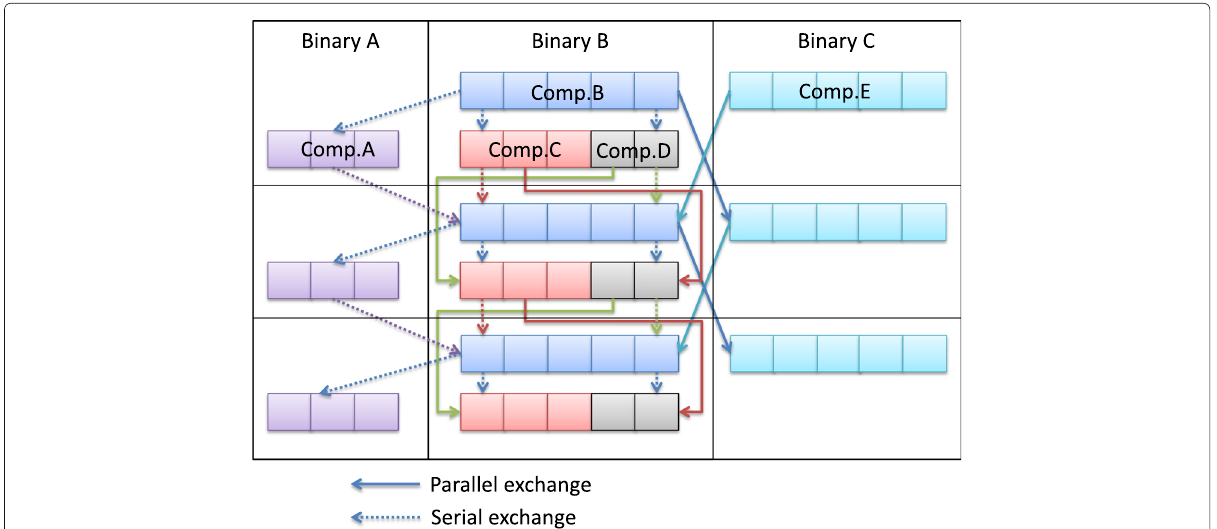
Fig. 1 Example of complex coupling pattern. The solid line indicates parallel exchange, and the dotted line indicates serial